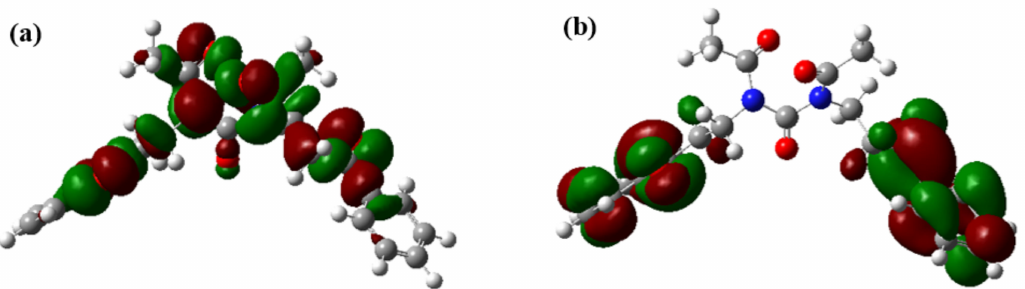
Figure 2. Charge distribution of organic matter frontier orbital in corrosion inhibitor (( a )-nucleophilic frontier orbital HOMO, ( b )-electrophilic frontier orbital LUMO).